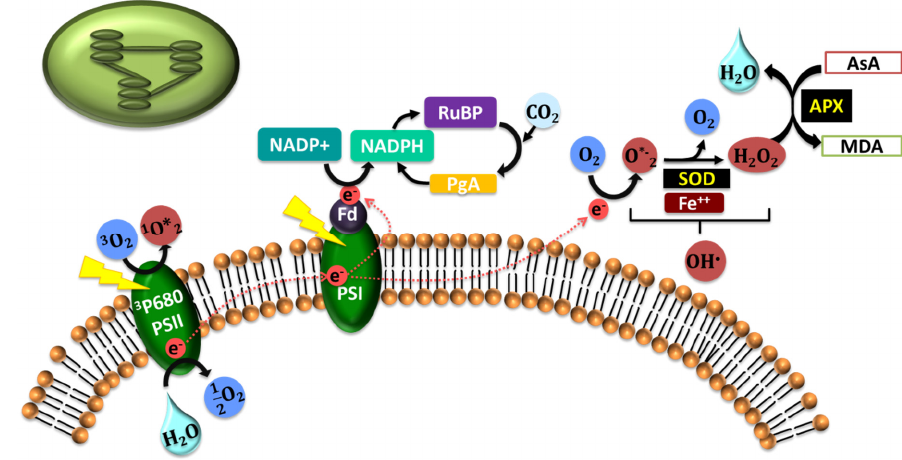
Figure 1. A diagrammatic representation of the processes in the chloroplast during stress where reactive oxygen species (ROS) is produced through inhibition of CO 2 , and low water levels are due to stress. The electron transport chain (ETC) in the photosystem (PS) is the main source of ROS in chloroplast.